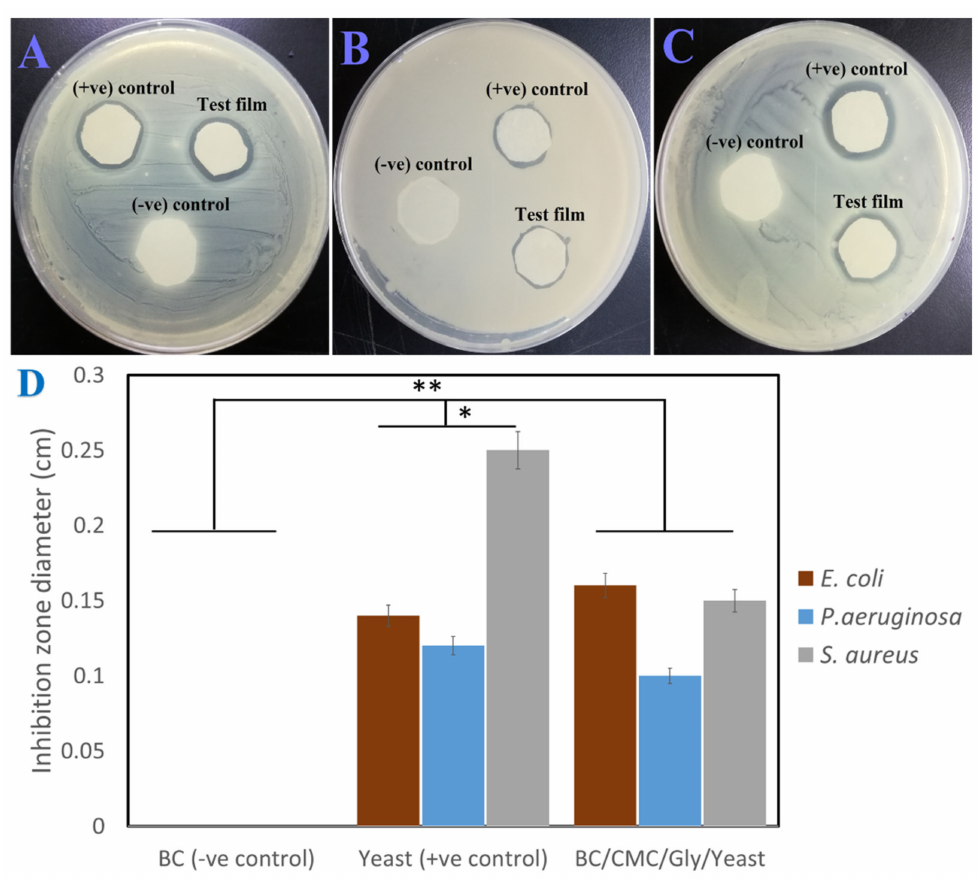
Figure 5. ( A – C ) Antimicrobial activity of BC/CMC/Gly/yeast composite films against Gram-positive ( S. aureus ) and Gram- negative bacteria ( P. aeruginosa and E. coli ) determined via disc diffusion method. A pure yeast extract and BC/CMC/Gly film were used as the positive control and negative control, respectively. ( D ) A quantitative presentation of inhibition zones produced by the sample and control against the tested microorganisms, * p < 0.05 and at ** p <